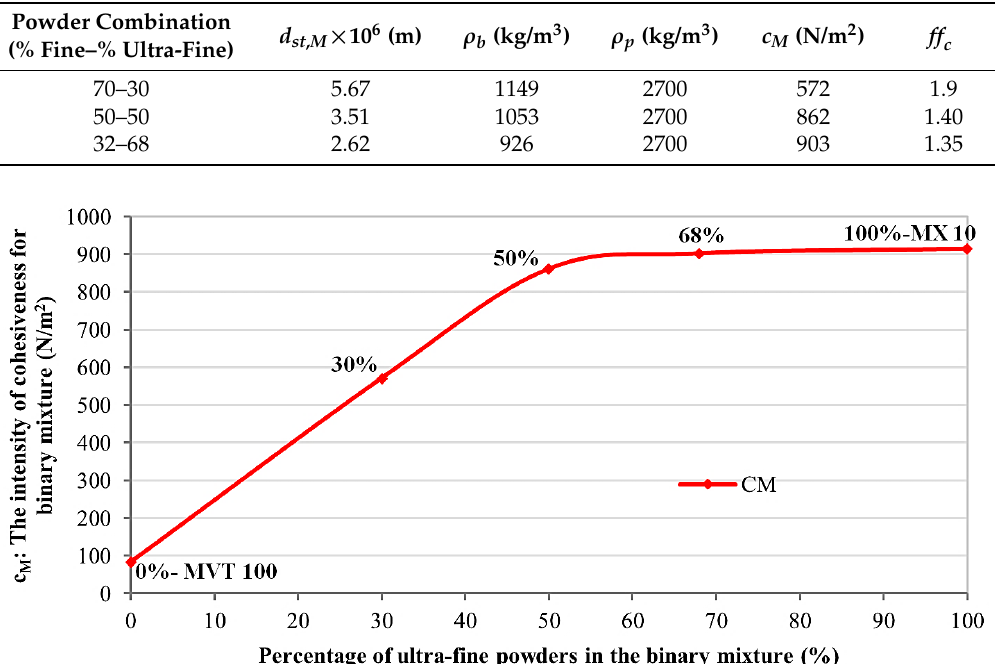
Figure 8. ( a ) Cumulative distribution function ( b ) Probability density function of the particle size for a binary mixture of 50% of ultra-fine + 50% of fine particles (laser Mastersizer 2000).